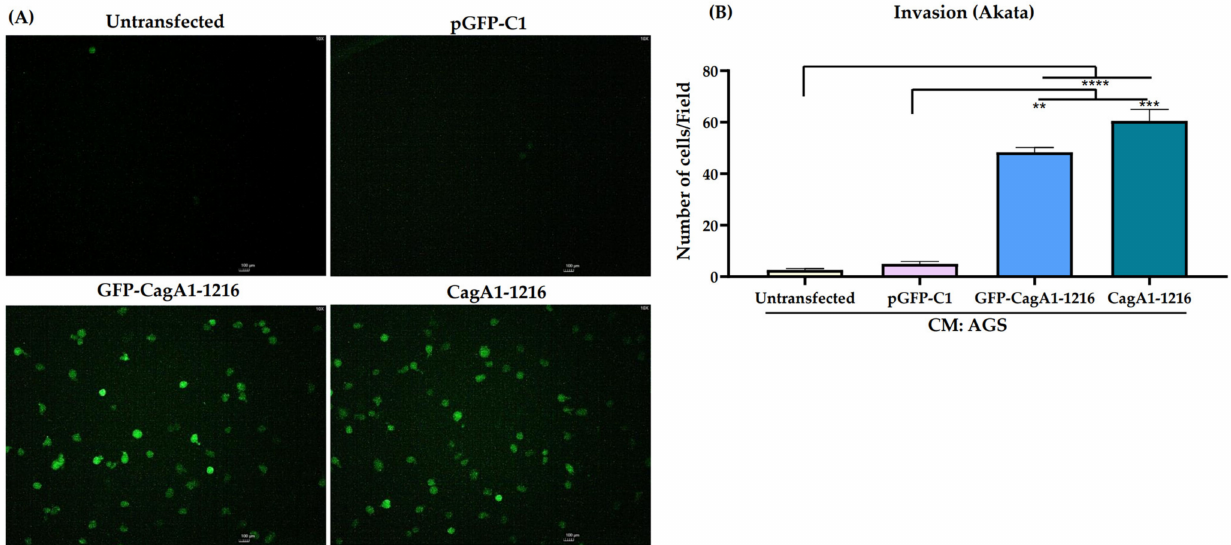
Figure 2. Overexpression of CagA in AGS cells chemoattracts EBV-infected B lymphocytes. ( A ) Rep- resentative fluorescence images of Akata cells (EBV-GFP positive cells) chemoattracted to conditioned media (CM) of AGS cells untransfected or transfected with empty vector (pGFP-C1), and full-length CagAs (GFP-CagA1-1216 or CagA1-1216). The scale bars indicate 100 µ m with magnification of 10 × . ( B ) Graph represents the mean ± SEM of the number of invading cells counted from 5 random microscope fields of three independent experiments. A non-parametric Kruskal–Wallis and Dunn’s post hoc tests were used for the statistical analyses. ** p < 0.01, *** p < 0.001 and **** p